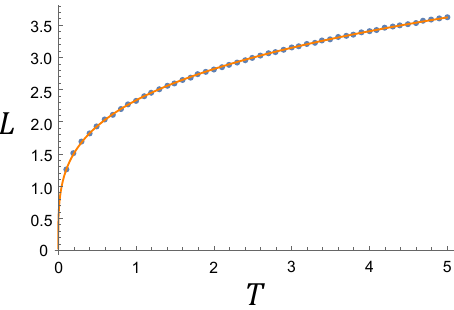
Figure 10 . Points: numerically calculated exponent L for various values of the temperature T . Line: a (cid:12)tting of the points by (cid:13)T c with constant (cid:13) and c